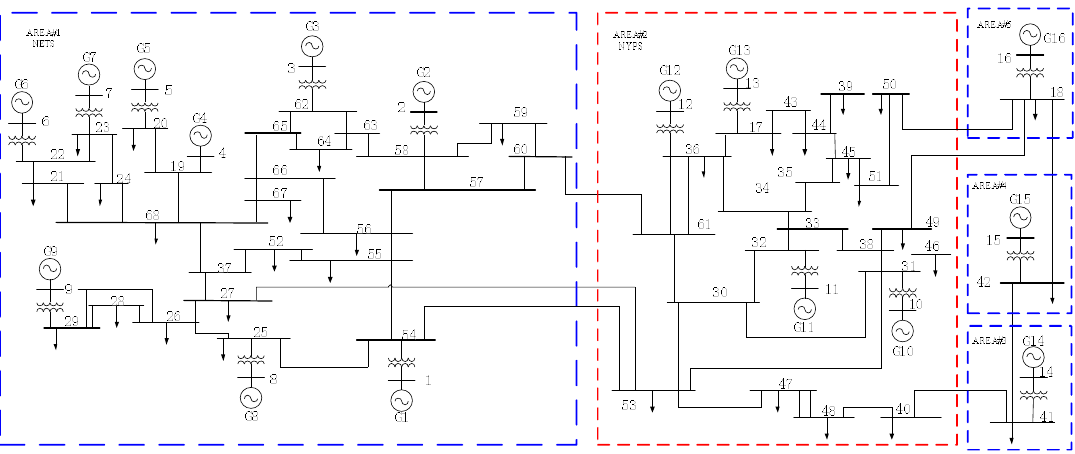
Figure 2. IEEE 16-machine 68-bus system diagram: with the increasing of wind penetration, the synchronous generators (SGs) of the New England test system (NETS) are gradually replaced by Type 4 WTGs; its behavior is similar to the 10 million megawatt cluster (TMMC).